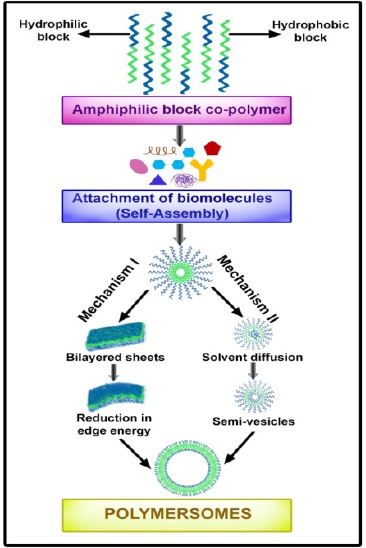
Figure 1. General process to obtain polymersomes.